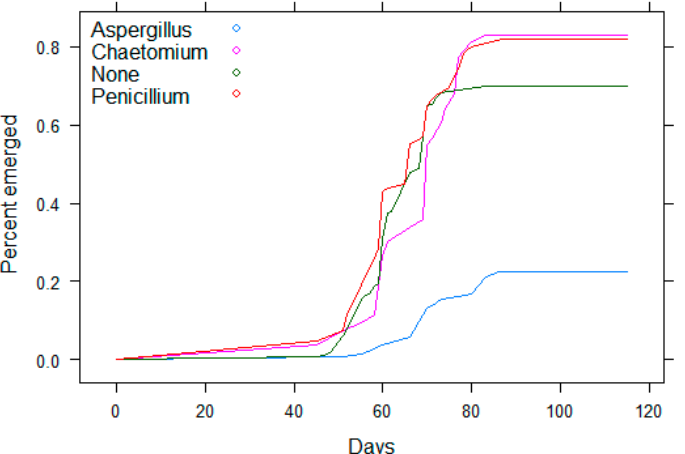
Figure 2. Survival analysis of emergence of date palm seedlings with or without fungi in the 600-seed experiment. Note delayed emergence due to Aspergillus sect. Nigri .